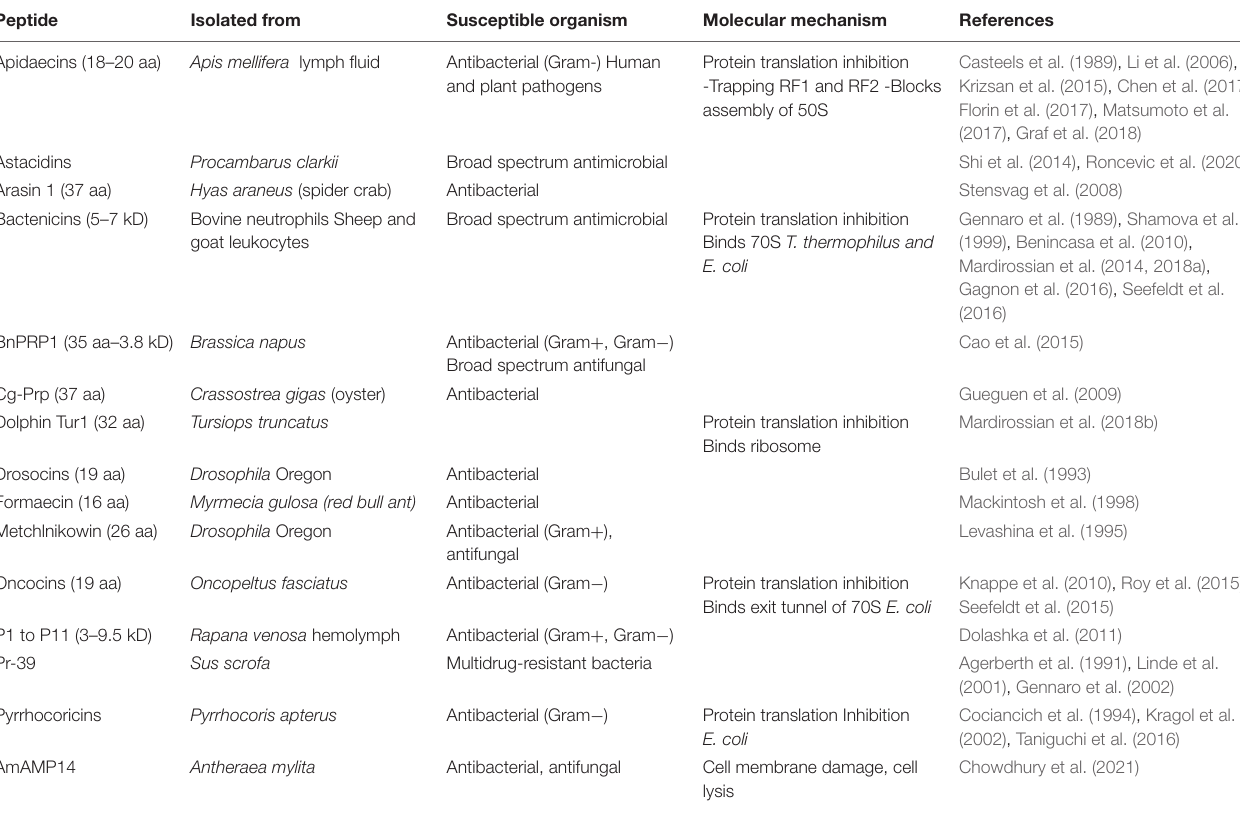
TABLE 3 | Proline-rich antimicrobial